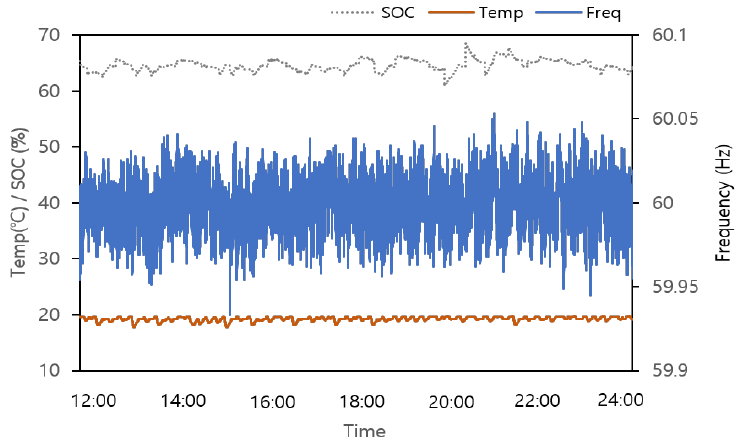
Figure 3. Actual steady-state operation of BESS on the grid.